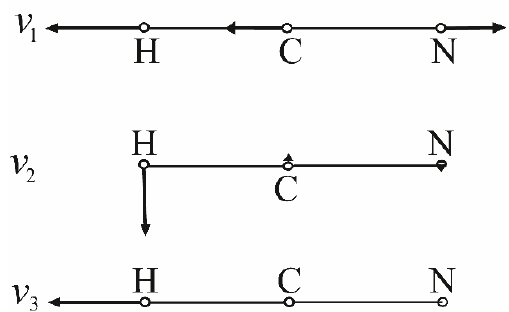
Figure 4. Vibrational pattern of hydrogen cyanide (HCN). Note that ν 1 implies an increase of the C-N distance.